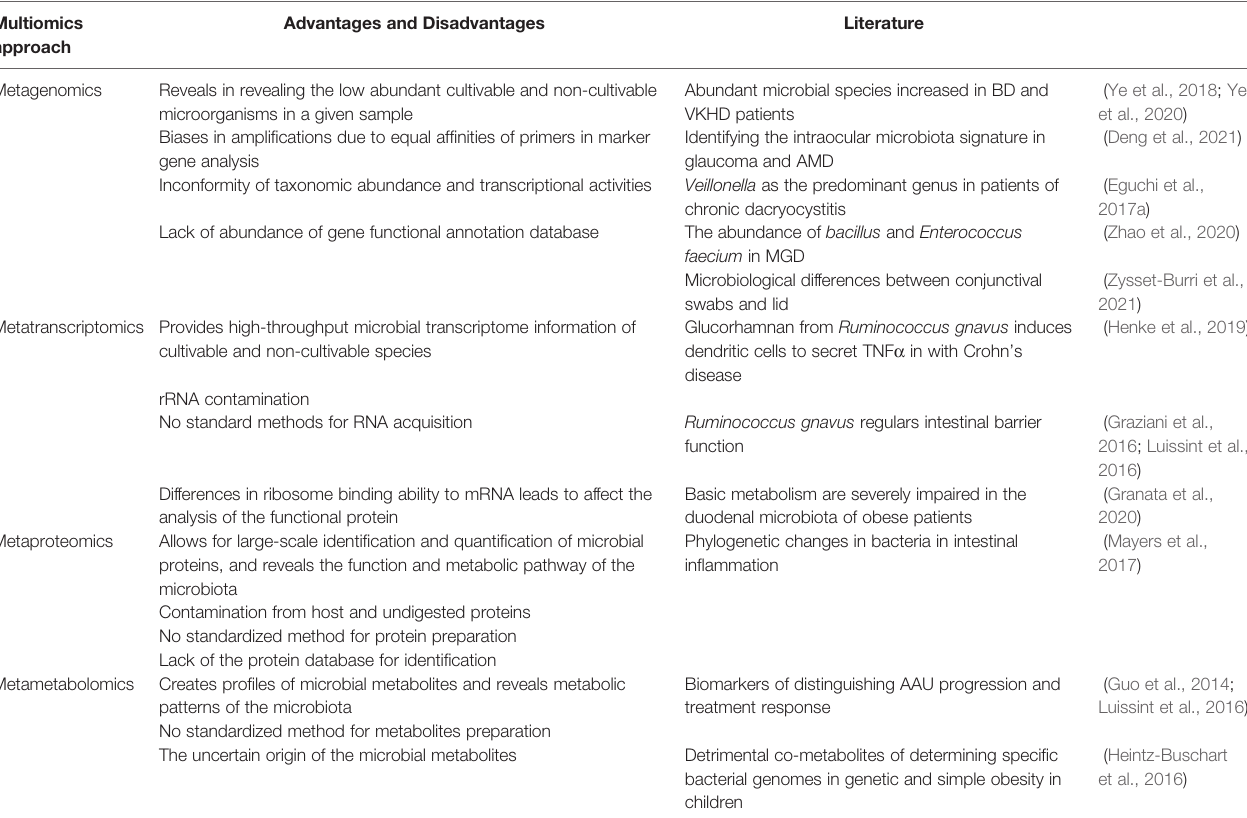
TABLE 1 | Advantages and disadvantages of the multiomics